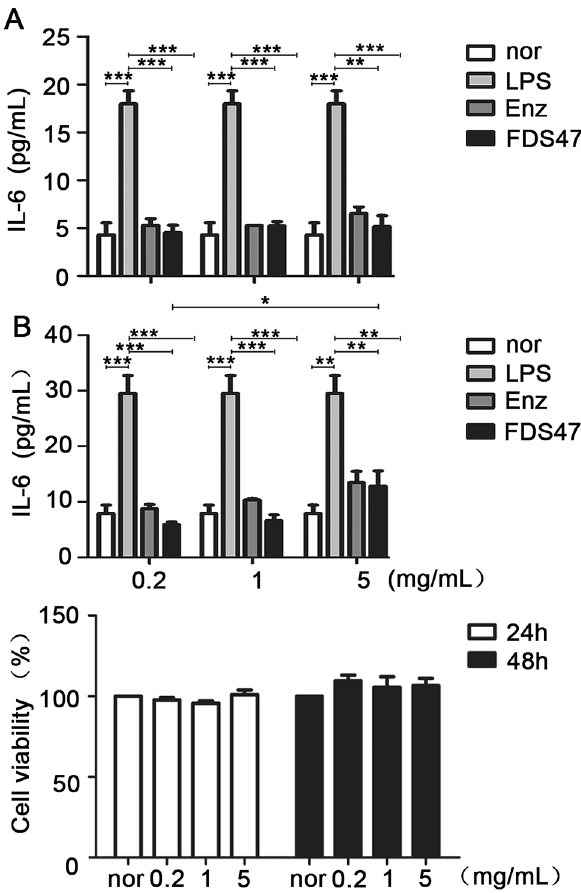
Figure 3. The IL-6 levels in caco-2 cells treated with different concentrations of Enz. and FDS47. FDS47 (fermented Danshen Sequence 47), Enz. (enzymolysis). IL-6 levels were examined in the supernatant of Caco-2 cells which were pretreated with 50 μg/mL LPS for 12 h, then treated with different concentrations of Enz. and FDS47 for 12 h ( A ) or 24 h ( B ). ( C ) The viability of caco-2 cells treated with different concentrations of FDS47. All groups (Nor, Enz., FDS47) were statistically analyzed with the LPS group. Group-to-group statistical analysis was performed at 24 h between 0.2 mg/mL FDS47 group, 1 mg/ mL FDS47 group and 5 mg/mL FDS47 group. (Data are expressed as means ± S.E., * p < 0.05, ** p < 0.01 and *** p <